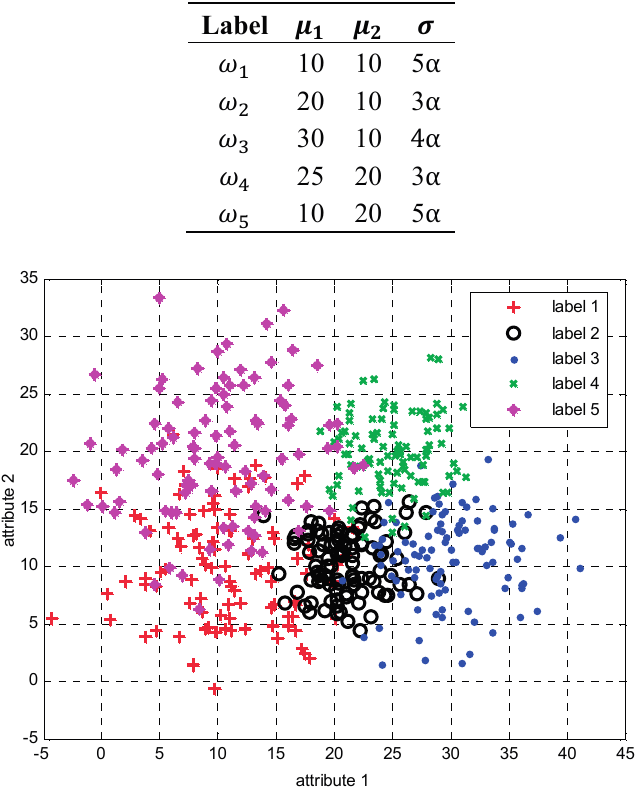
Table 1. Data generation parameters.